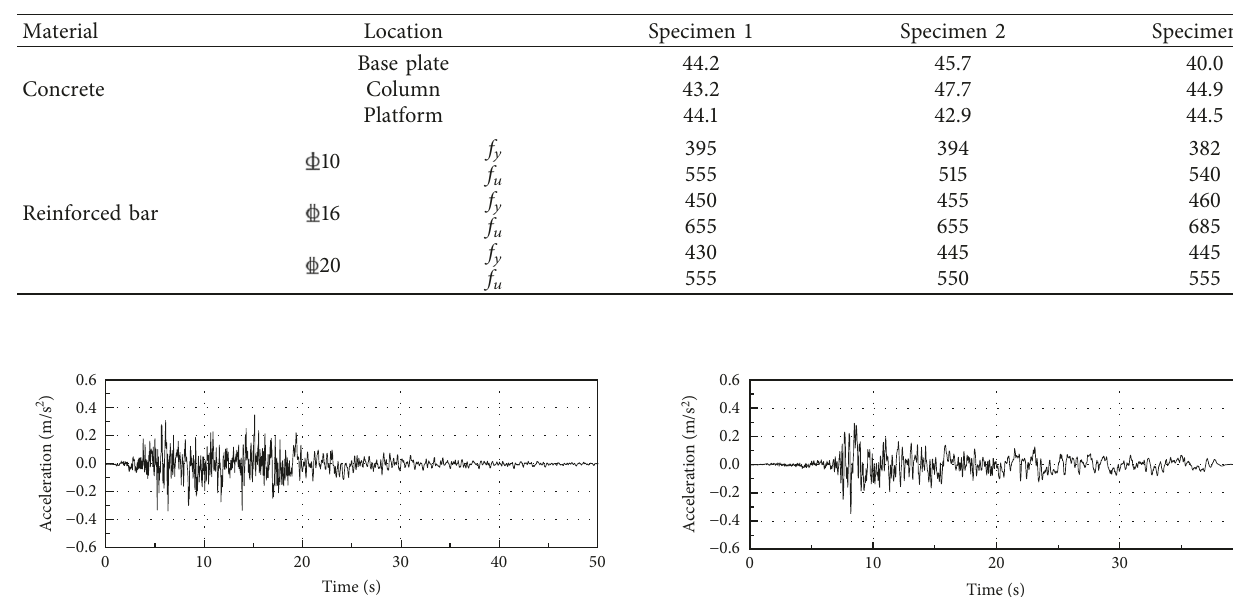
Table 2: Material test results (MPa).